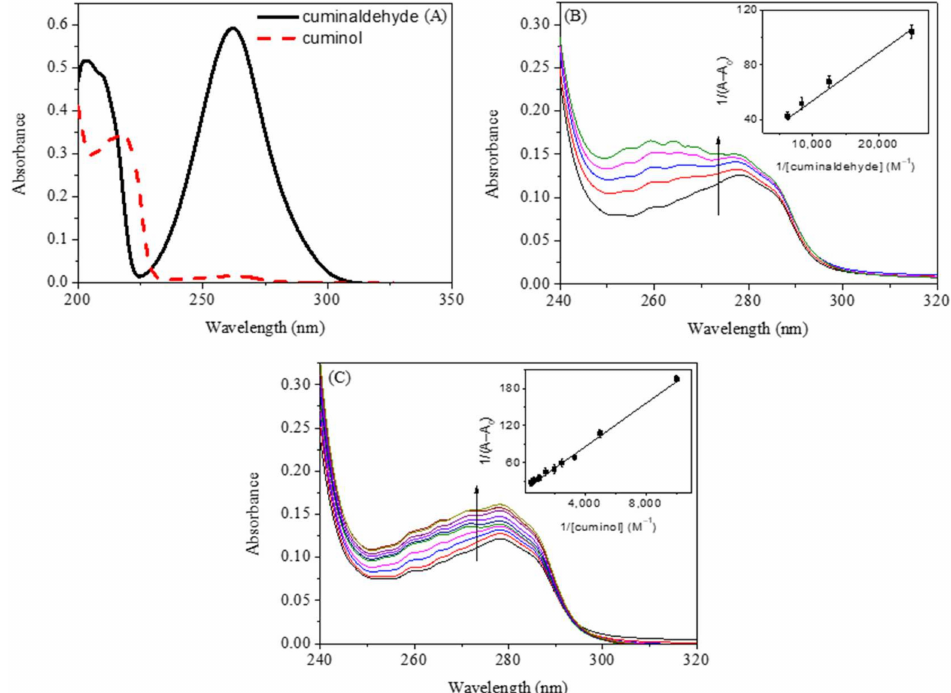
Figure 1. ( A ) UV-visible absorption spectra of cuminaldehyde and cuminol. The concentration of both substances was 40 µ M. ( B ) Different UV-visible spectra of HSA in the absence and presence of cuminaldehyde (0, 40, 80, 120 and 160 µ M) and ( C ) cuminol (0, 100, 200, 300, 500, 700, 1000 and 2000 µ M). The concentration of HSA was 3.0 µ M at 25 ◦